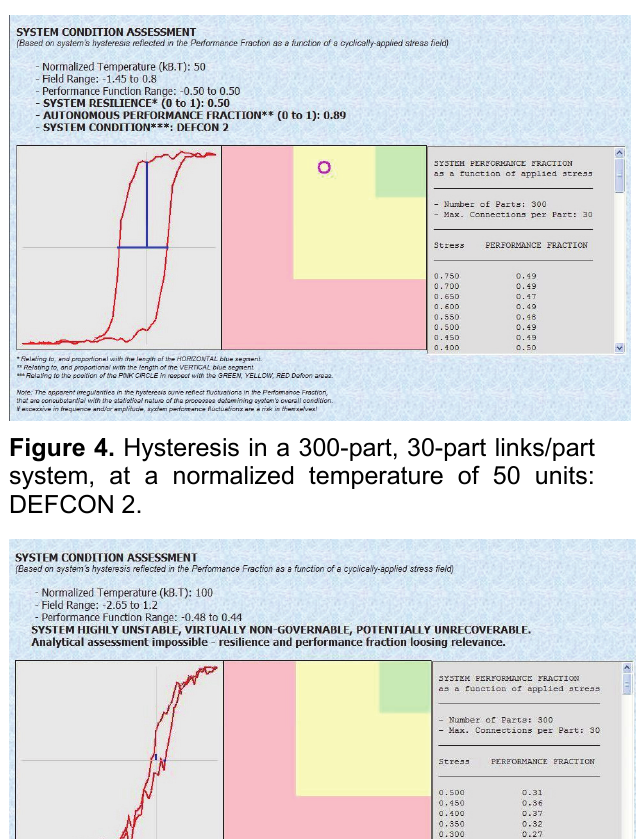
Figure 3. Hysteresis in a 300-part, 30-part links/part system, at a normalized temperature of 20 units: DEFCON 3.